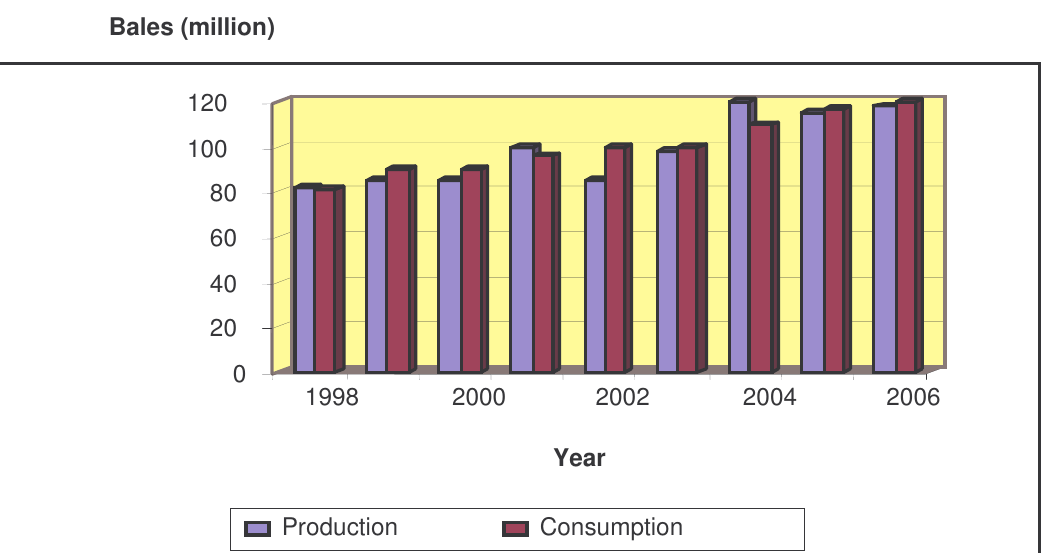
Figure 1: World cotton production and